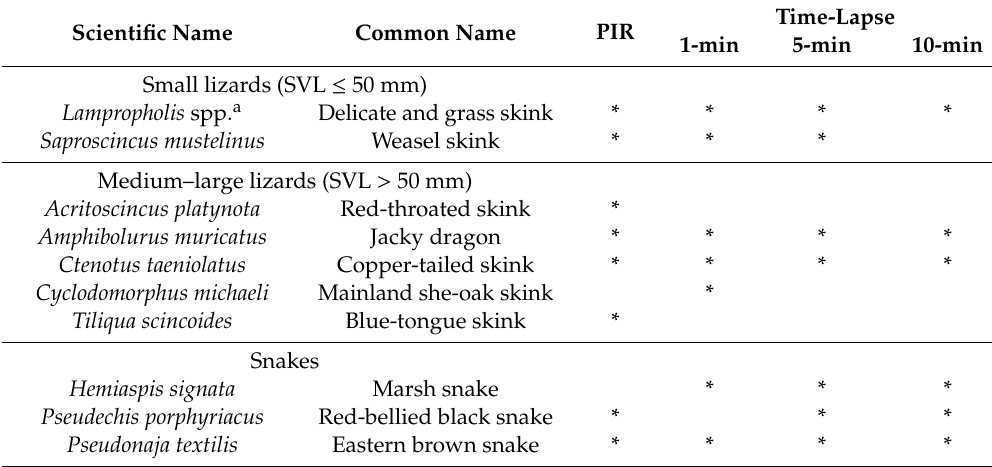
Table 2. Squamate species detected with either passive infrared (PIR) or time-lapse (TL) trigger for 1-, 5-, and 10-min detection